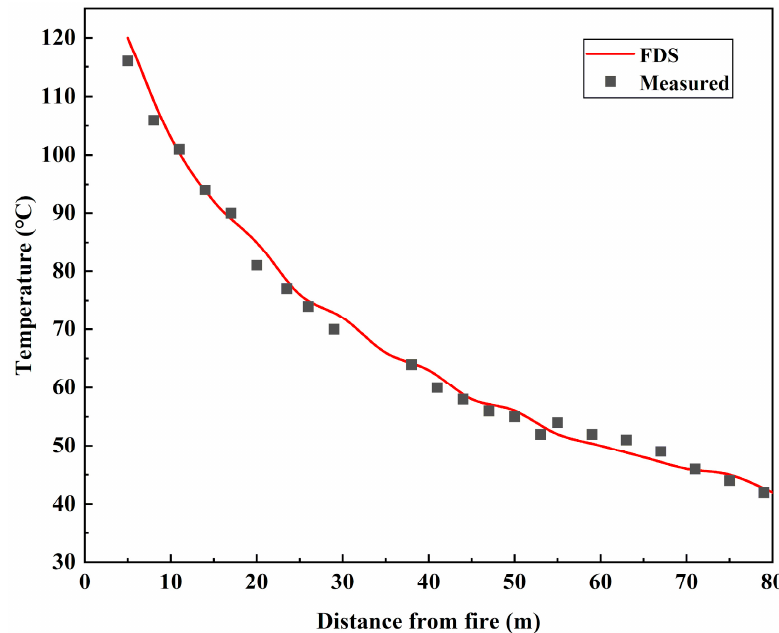
Figure 5. Comparison of temperature distributions between simulation and experiment.